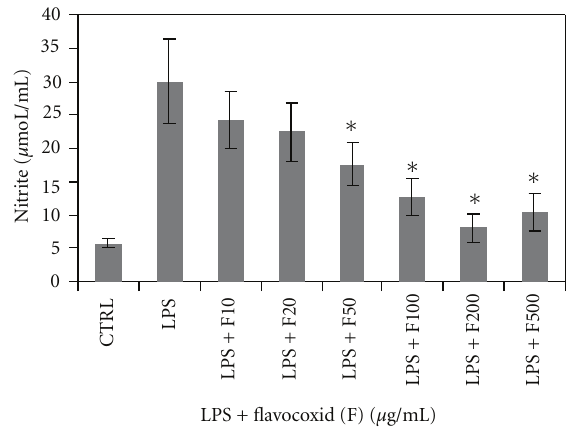
Figure 4: Nitrite levels in rat peritoneal macrophages exposed to flavocoxid (F) at 10, 20, 50, 100, 200, and 500 μ g/mL in the presence of lipopolysaccharide